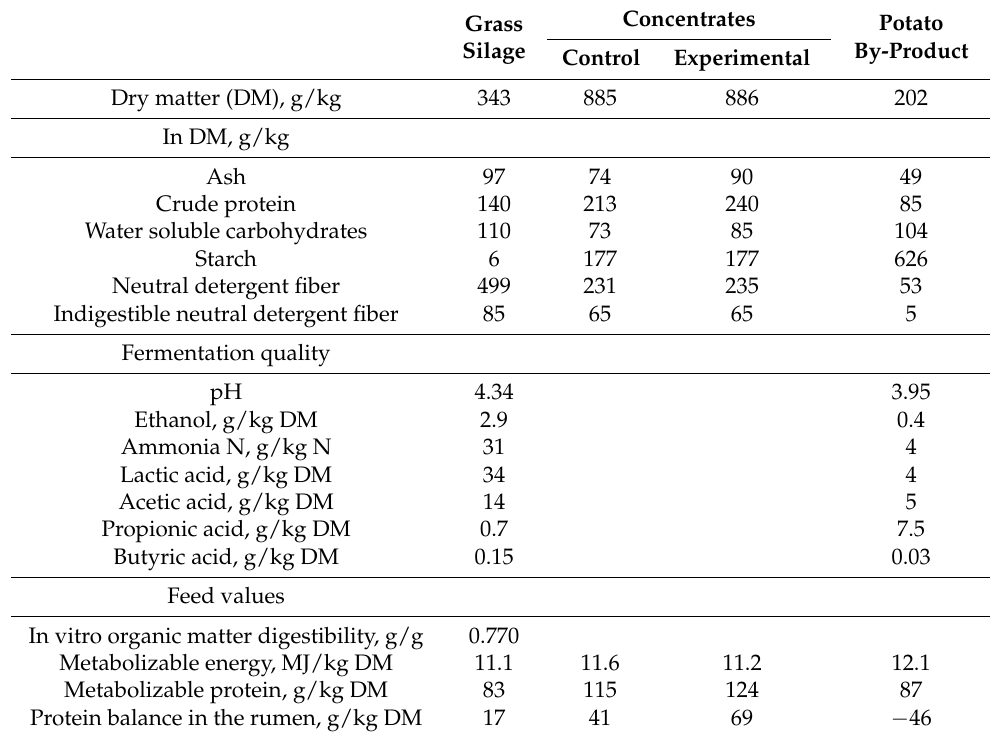
Table 2. Chemical composition, fermentation quality and feed values of the feeds used in the dairy cow feeding experiment (Experiment